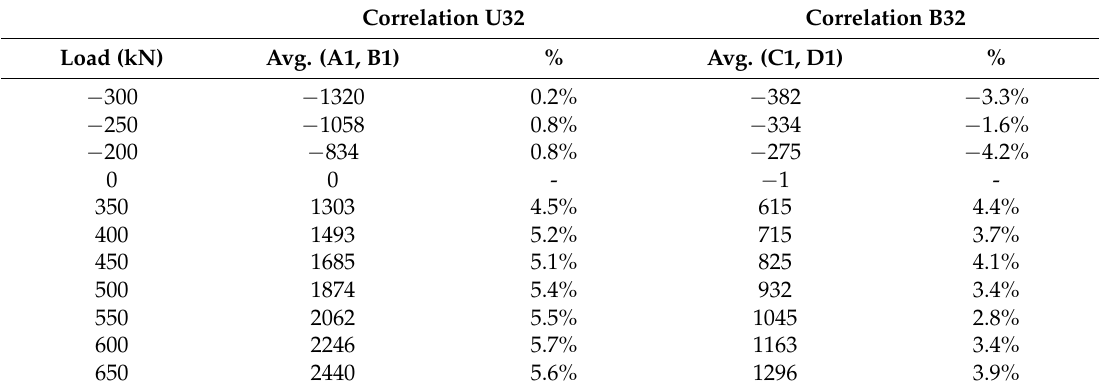
Table 3. Limit Load Correlation.